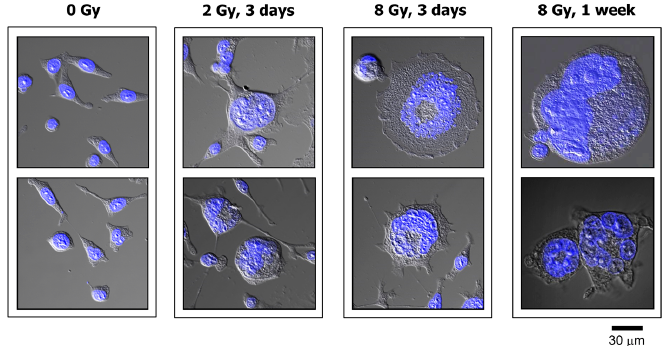
Figure 1. Confocal microscopy images showing nuclear morphology of HCT116p21 − / − cells before and at indicated times after irradiation. Nuclear content (DAPI staining) is shown in blue. All images were acquired at the same magnification.